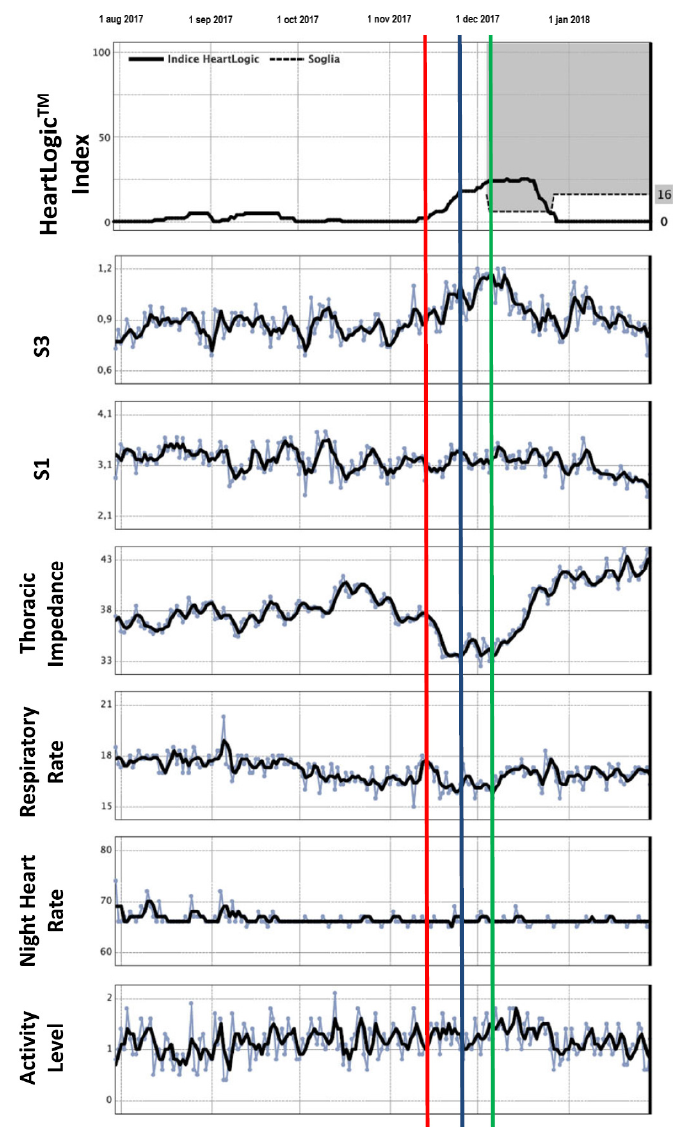
Figure 4. Example of HeartLogic TM . At the red line, the patient discontinued diuretic therapy, resulting in weight gain. Diuretic therapy was then restored (green line). The HeartLogic TM index analysis showed crossing of the alarm threshold value, set at a default value of 16 (blue line), with an early warning 10 days in advance compared with clinical evaluations. After therapy restoration, the HeartLogic TM index normalized. Reproduced and modified with permission from Capucci et al. (ESC Heart Fail, 2019) [20].